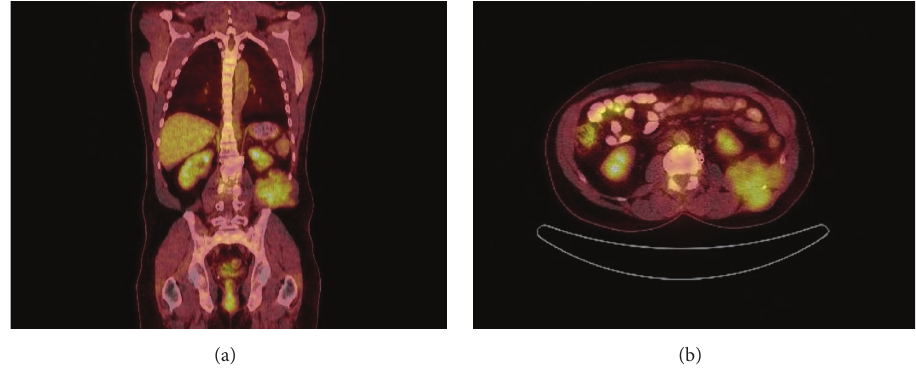
Figure 2: PET scan shows tumor recurrence.